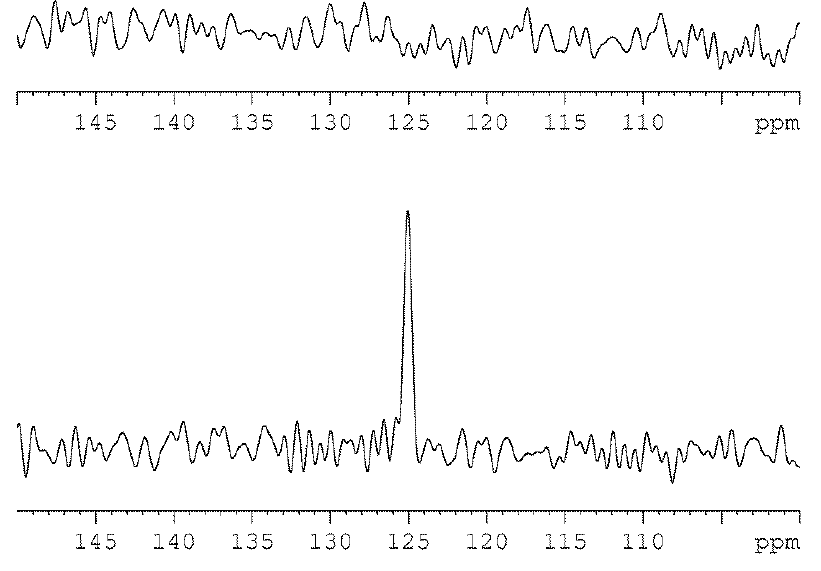
Figure 13. 13 C MAS NMR spectra of a sample of Afghan lapis lazuli ( bottom ), and a sample of synthetic ultramarine ( top ).